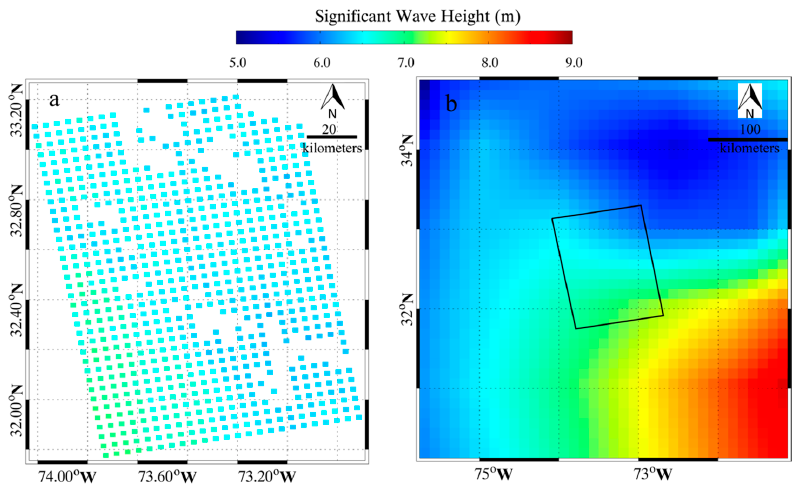
Figure 10. ( a ) The SAR-derived SWH from TD-X image over tropical cyclone Sandy at 22:49 UTC on 28 October 2012. ( b ) ECMWF reanalysis SWH data at 00:00 UTC on 29 October 2012 at a 0.125° gird, in which the rectangle represents the coverage of TD-X image.